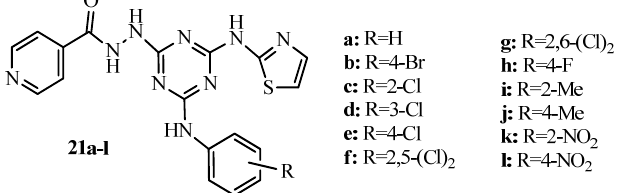
Figure 9. Structures of N-(4-(arylamino)-6-(thiazol-2-ylamino) 1,3,5-triazin-2-yl) isonicotinohydra- zides.